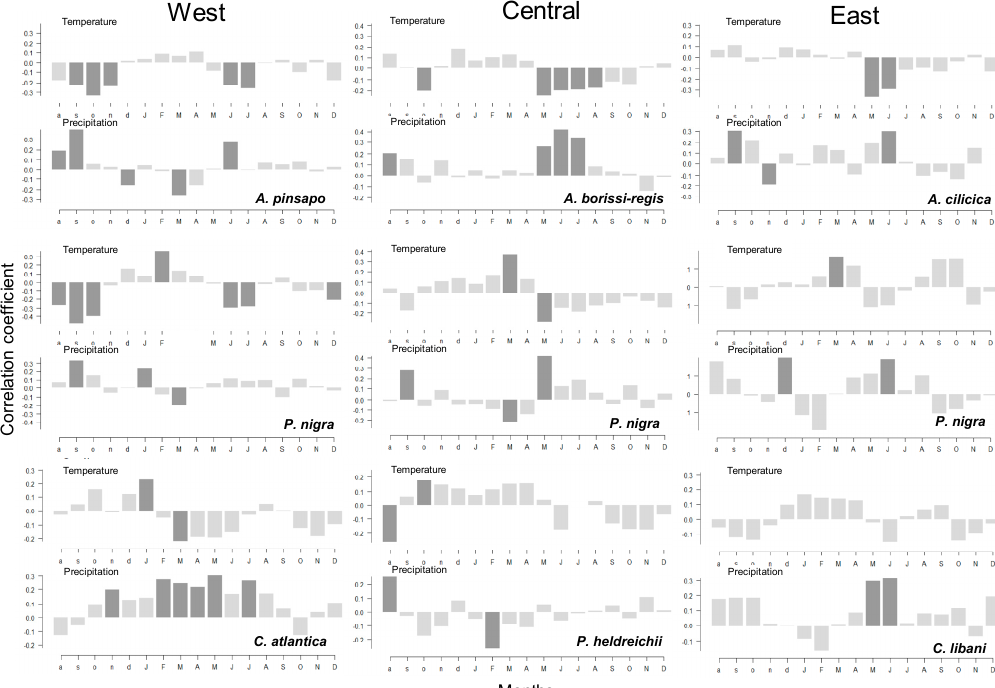
Figure 3. Bootstrapped tree growth–climate associations for the studied sites assessed by relating ring-width indices (TRWi) to seasonal and monthly climatic variables (mean temperature and precipitation) for the 1946–2010 period. The temporal window of analyses ranges from the previous August (previous-year months and seasons are abbreviated in uppercase letters) to the current December (current-year months are abbreviated in lowercase letters). Significance levels are shown in darker grey color ( p < 0.01). Sites’ codes are as in Table 1.